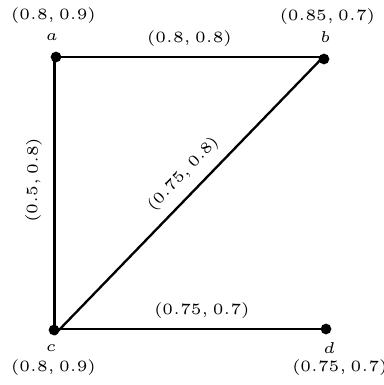
Figure 4.6: A triangulated q -rung orthopair fuzzy graph G Figure 15. A triangulated q -rung orthopair fuzzy graph G